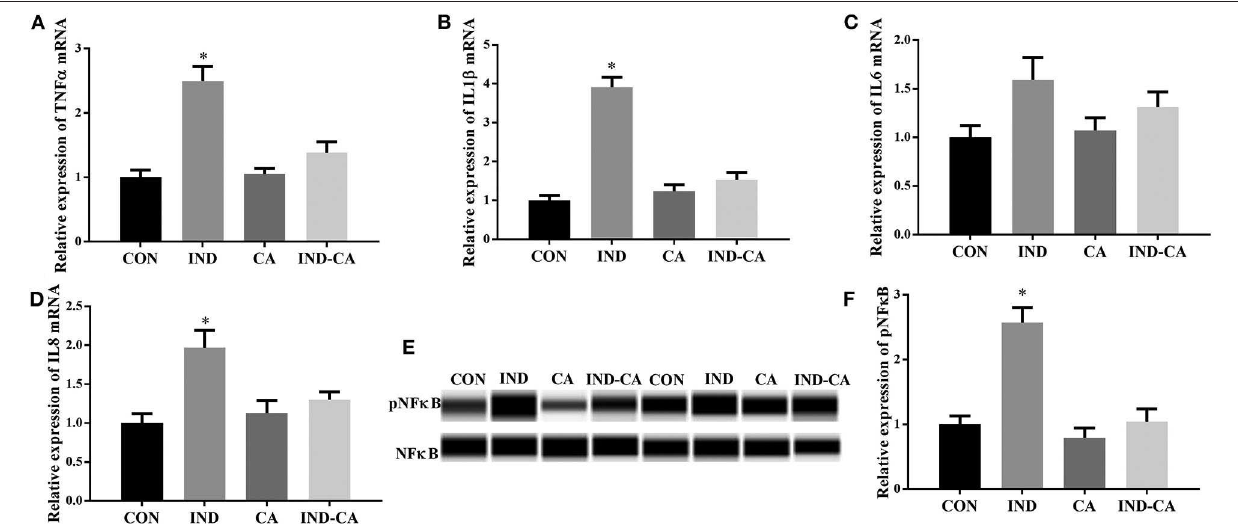
FIGURE 2 | Chlorogenic acid prevented inflammation in the colons of indomethacin-treated mice. Relative mRNA expression of TNF α (A) , IL1 β (B) , IL6 (C) , and IL8 (D) ; (E) pNF κ B expression determined by the WES Simple Western System. A full image of panel (E) shown in Supplementary Figure 1 ; (F) Relative abundance of pNF κ B, (F) is the quantification of the WB in E. Values are expressed as mean ± SEM, n = 8 for results of gene expression and n = 3 for results of protein expression. * P <